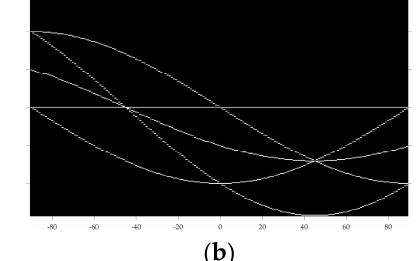
in a black background; ( b ) Hough